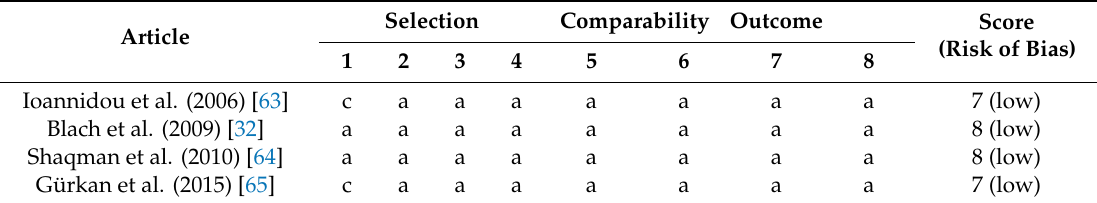
Table 2. Newcastle-Ottawa Scale (NOS) for case-control studies in the systematic review according to the eight-items.